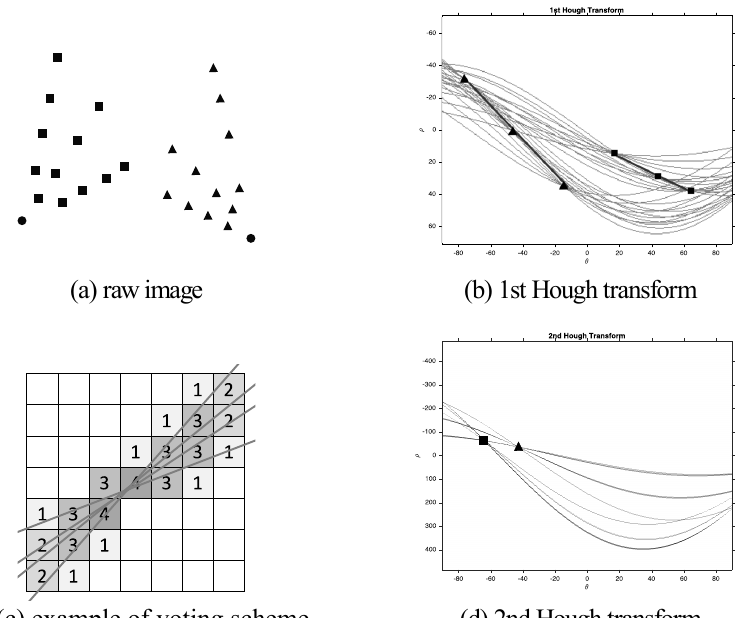
Figure 2. An example of a double Hough transform, ( a ) raw image: two group of dots are marked as rectangles and triangles; ( b ) first Hough transform finding the collinear points; ( c ) an example of voting scheme: the numbers of each accumulator represent how many lines are passing through it; ( d ) high peaks extracted from ( b ) are transformed as lines in the second Hough